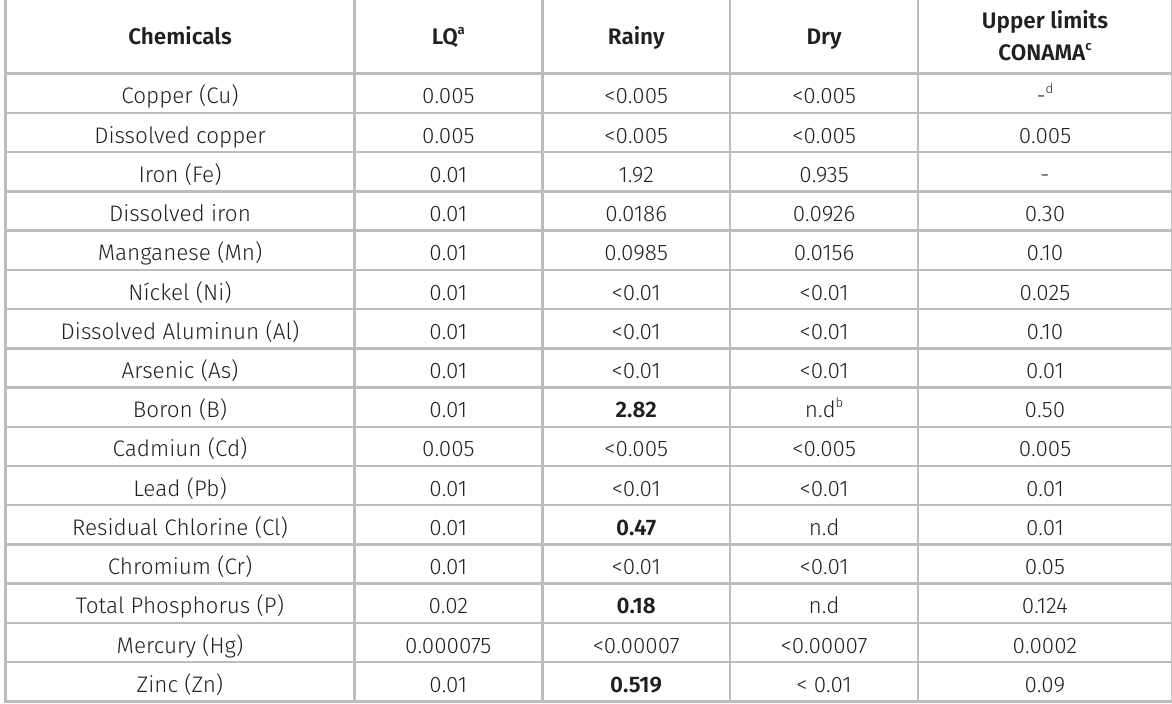
Table II. Chemical analyses (concentration in mg/L) of water at the vicinity of the Itaqui Port Complex in Maranhão State, Northeastern Brazil (dry and rainy seasons, 2015), compared to the Brazilian environmental legislation (CONAMA-Brazilian National Environmental Council, Resolution 357/05, class 1 brackish